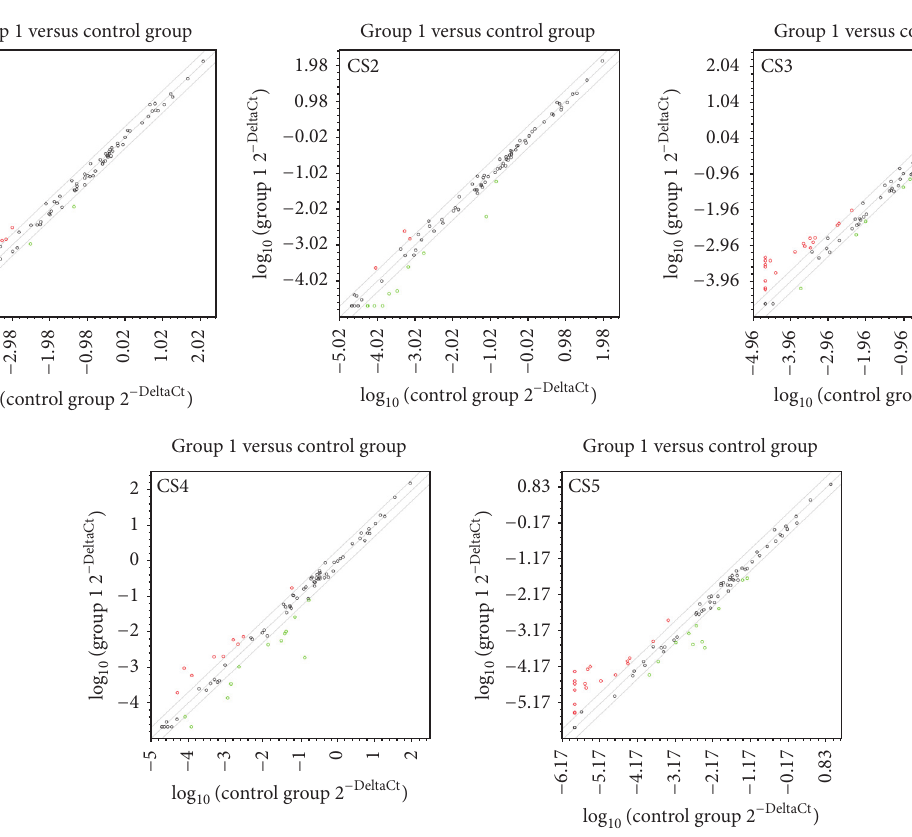
Figure 6: Graphical representation of gene expression results. Genes differentially expressed between passage 3 (P3) to P5 in each created comparison set (CS1–CS5) and their fold regulation values are indicated in chart. Scatter plot for 84 tested genes of canine adipose derived mesenchymal stem cells in each created comparison set